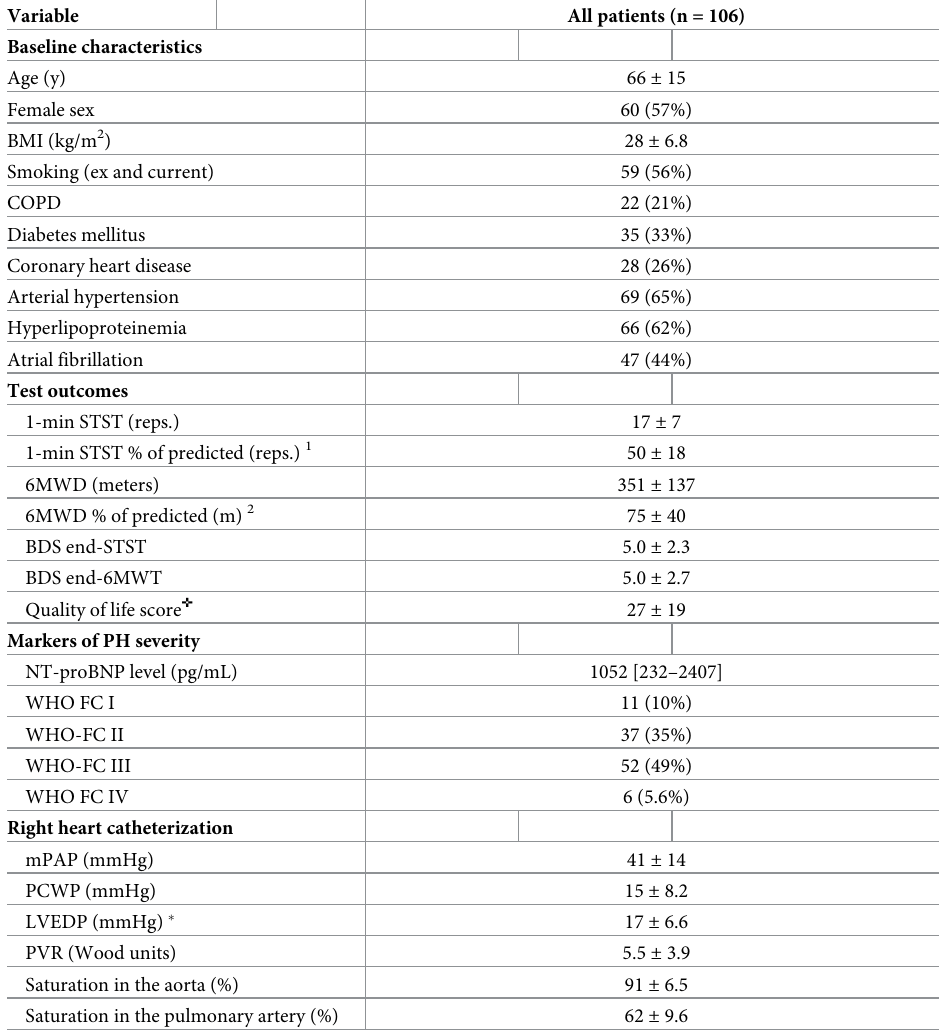
Table 1. Clinical